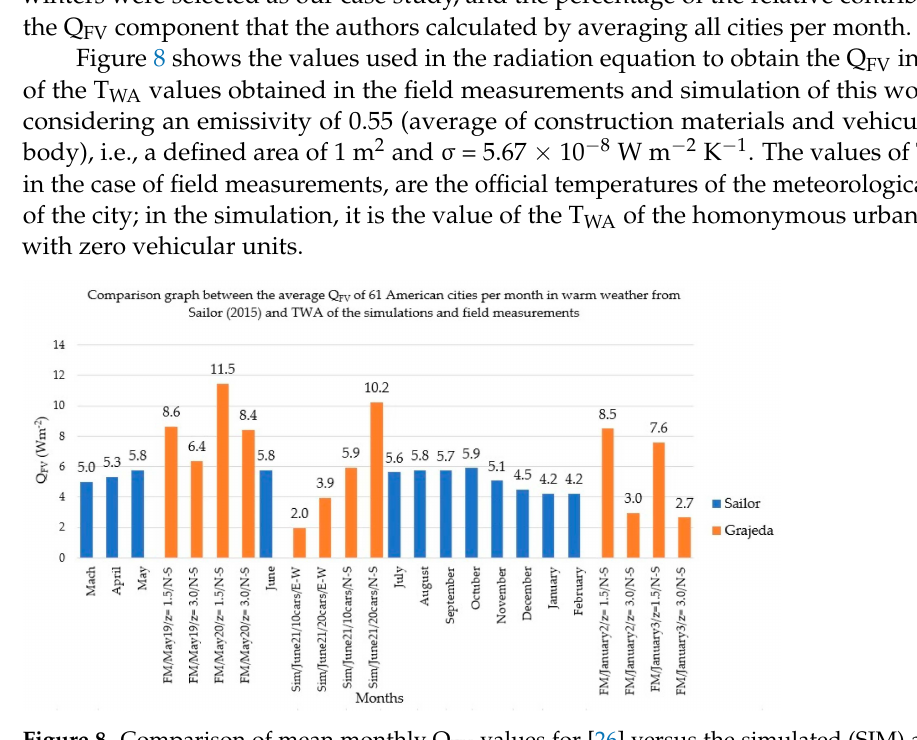
Figure 8. Comparison of mean monthly Q FV values for [26] versus the simulated (SIM) and field- measured (FM) T WA